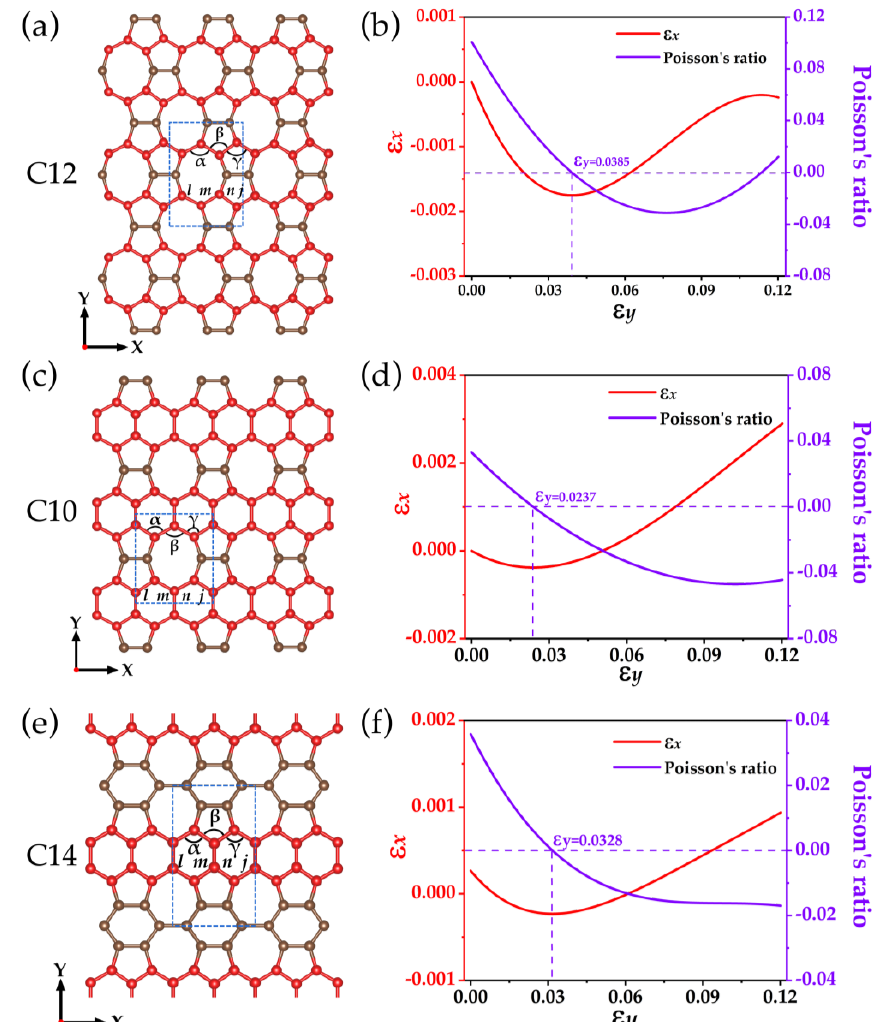
Figure 3. Structures and mechanical responses of C12, C10, and C14. ( a , c , e ) Three structures containing zigzag carbon chains are marked as C12, C10, and C14, separately. The bond angle and the bond length of these structures are marked with α , β , γ and l , m , n , j , respectively. The unit cell in these structures is outlined with blue rectangular dotted boxes, and zigzag chains in these structures are colored red. The mechanical responses for structures ( a , c , e ) are shown in ( b , d , f ), separately. These red lines indicate the response of the driven strain under the uniaxial strain along the y -axis, and the purple line represents the Poisson’s ratio under the uniaxial strain along the y